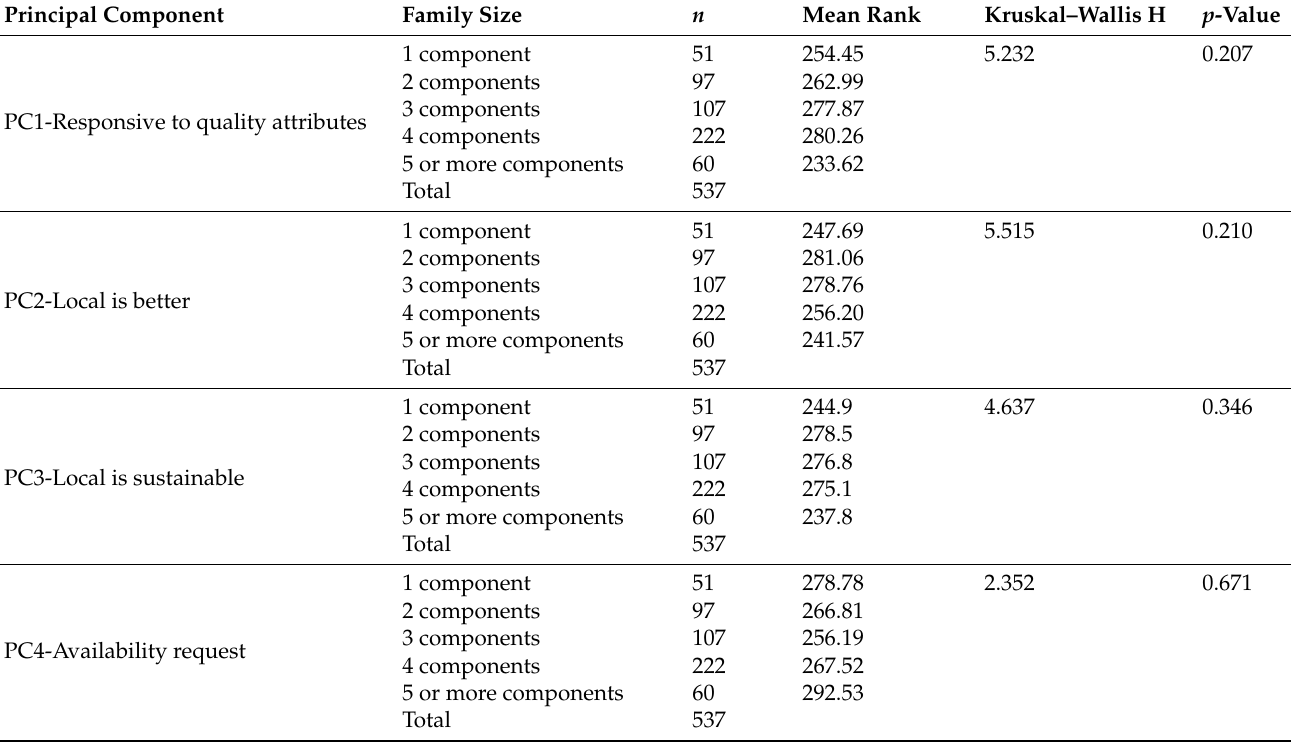
Table 8. Effect of family size on the principal components’